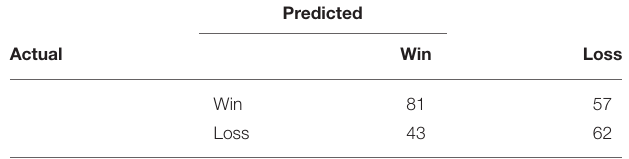
TABLE 5 | Classification matrix.